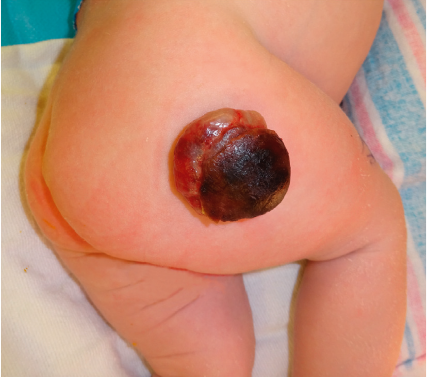
Figure 1: Cutaneous mass of the right thigh.